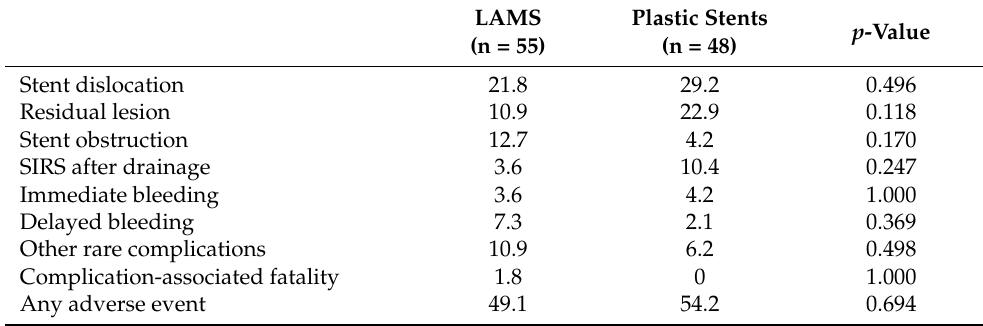
Table 3. Comparison of adverse events frequency between lumen-apposing metal stent (LAMS) and plastic stent